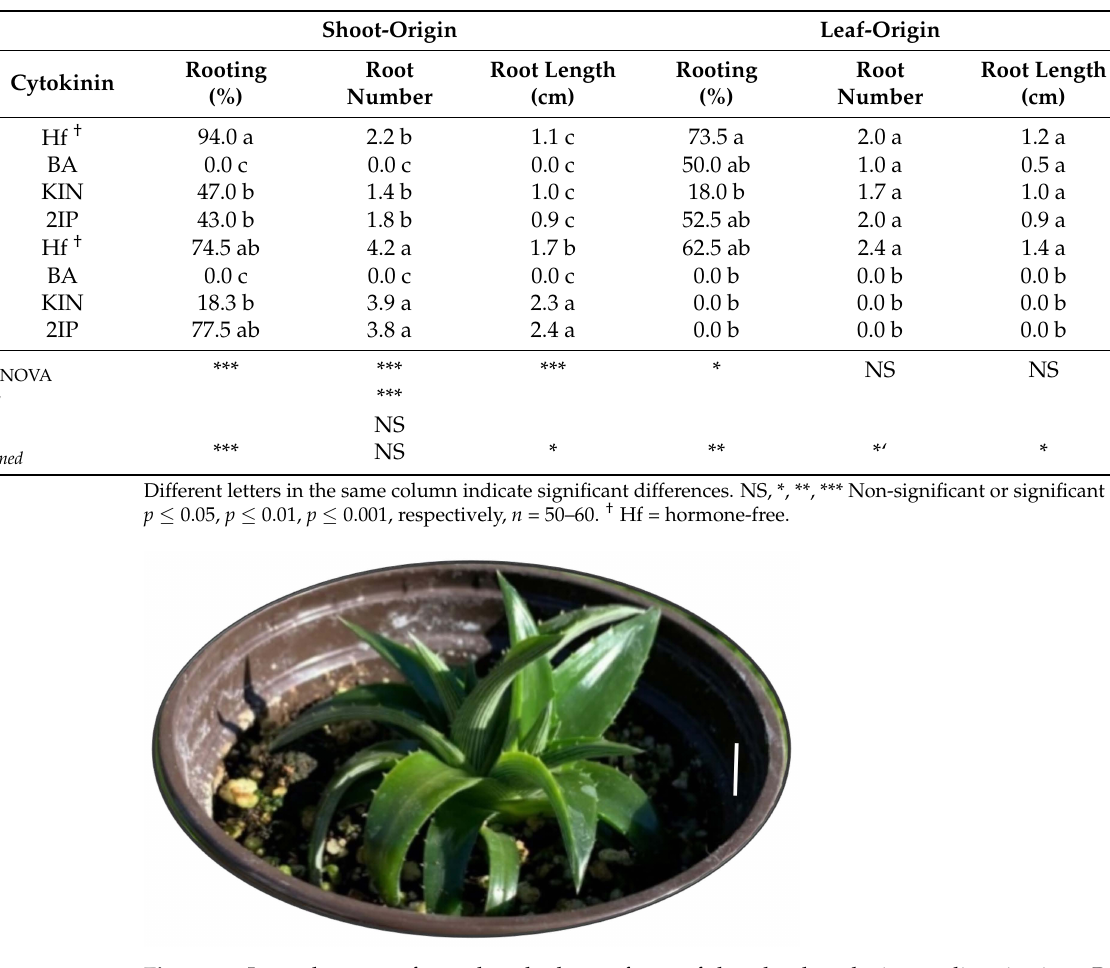
Figure 5. Lateral sprouts formed at the base of one of the plantlets during acclimatisation. Bar represents length of 1